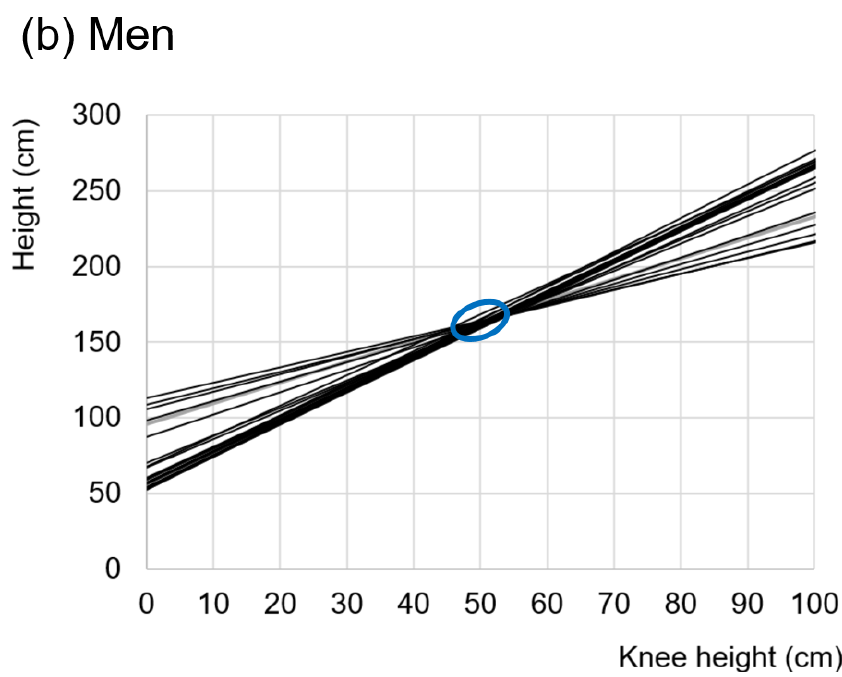
Figure 2. Family of straight lines of eqs of the form height = β o + β 1 ∙ KH + ℰ . The blue ellipses indicate the area of intersection of the lines.